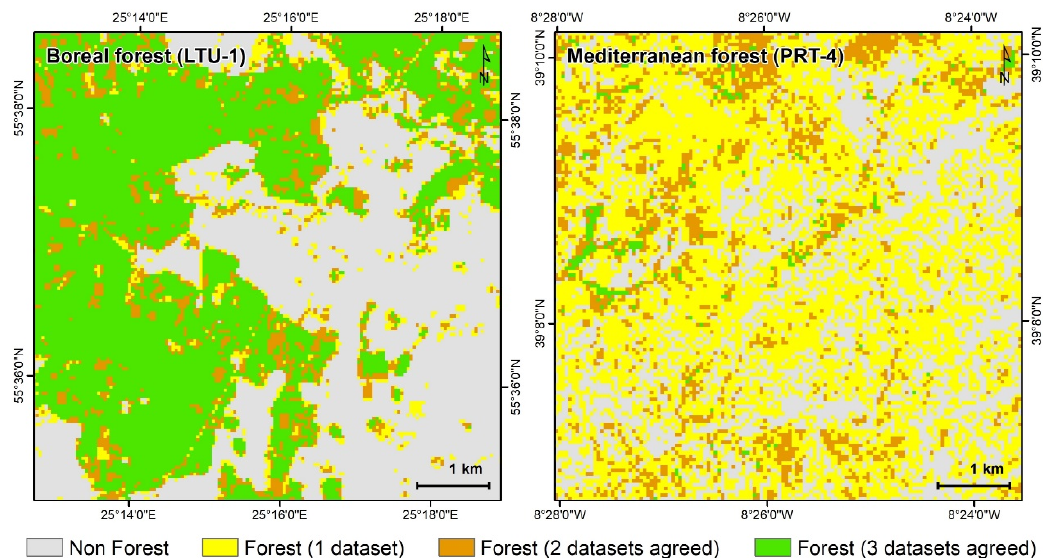
Figure 5. Comparison between two forests in the three datasets: Boreal with high accuracy ( left ); and Mediterranean with low accuracy ( right ).